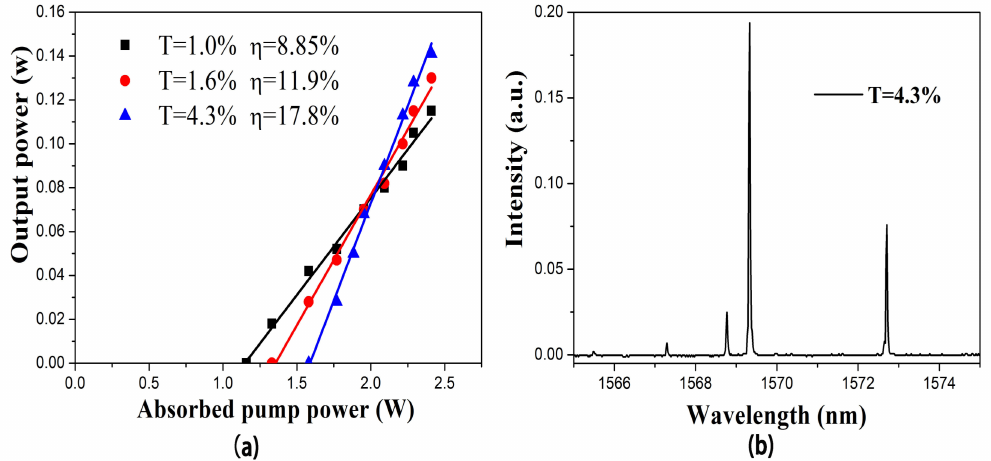
Figure 8. ( a ) Continuous-wave output power realized in the Er:Yb:GMB crystal for different transmissions T; ( b ) Laser spectra of Er:Yb:GMB when the absorbed pump power is 2.4